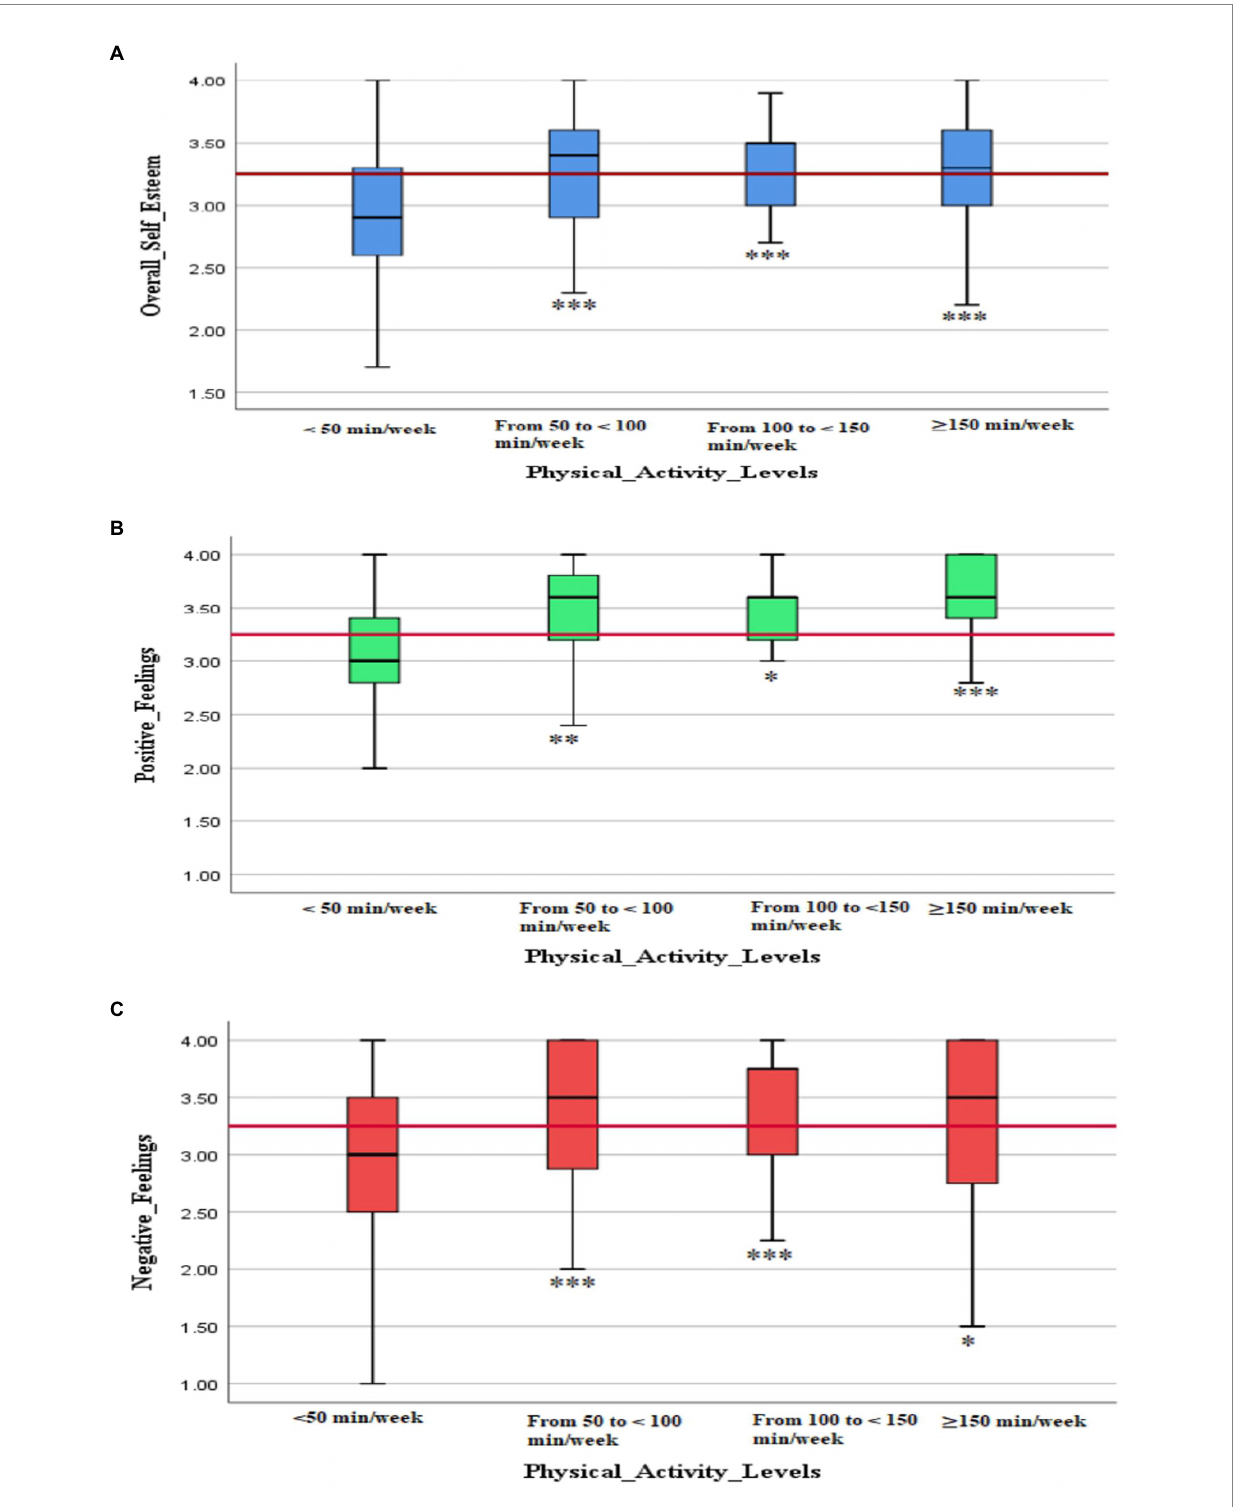
FIGURE 3 Levels of overall self-esteem (A) and positive (B) and negative (C) feelings according to the weekly physical activity level in Saudi participants with physical disabilities ( N = 582). * < 0.05, ** < 0.01, *** < 0.001 differs from subgroup